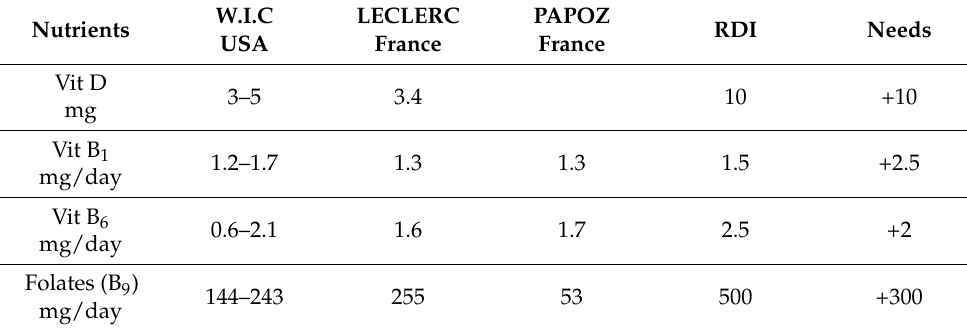
Table 5. Survey vitamins and